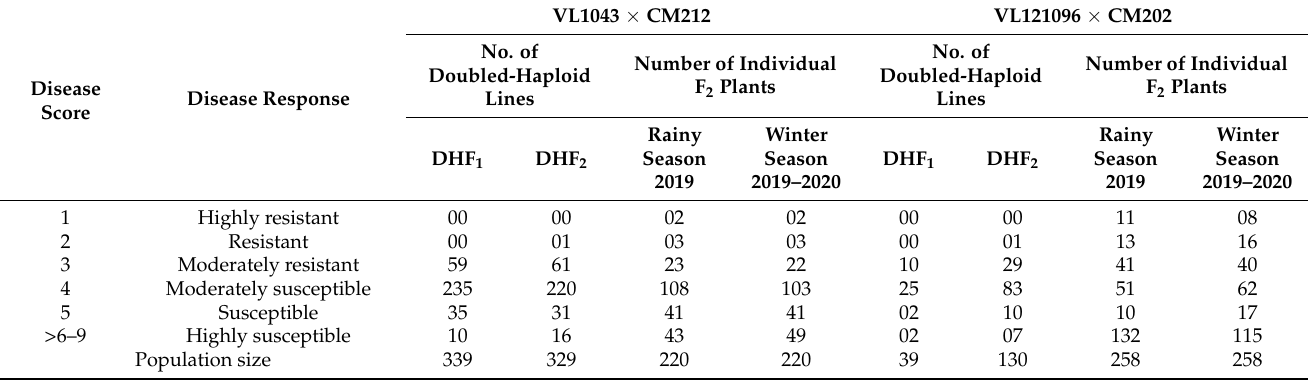
Table 4. Classification of doubled-haploid lines induced from F 1 and F 2 plants into different response groups based on their BLUP values across two